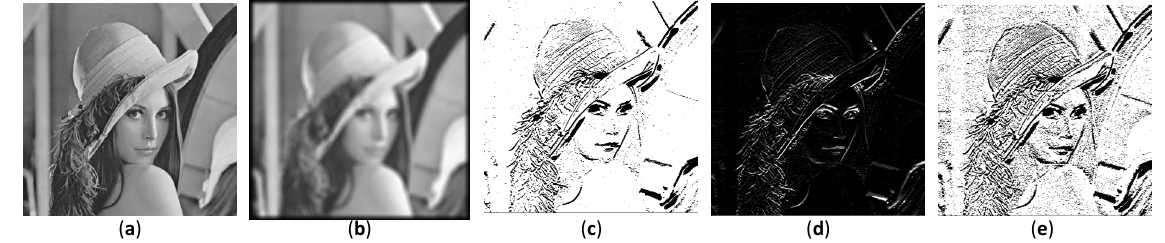
Figure 7. Demonstration using “Lena” to present ( a ) original image, ( b ) blurred image, ( c ) edge pixel image, ( d ) smooth pixel image, and ( e ) texture pixel image.